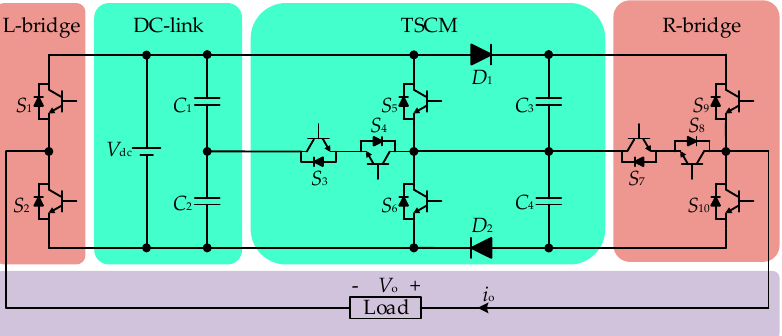
Figure 3. The proposed nine-level inverter.